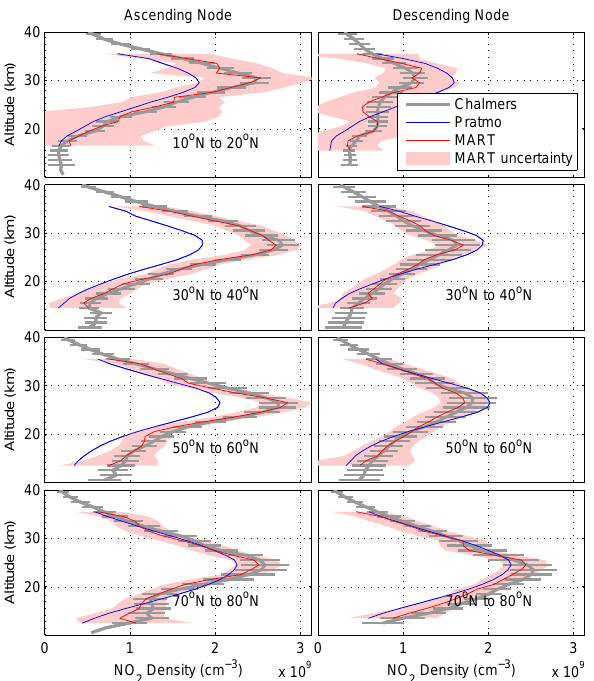
Fig. 5. Selected zonal mean profiles from one day of OSIRIS measurements. Each panel compares the zonal average of our re- trievals and the official OSIRIS version 3.0 product. Included in each panel is the zonal average of the apriori/initial guess profile (labeled Pratmo). In both cases, the uncertainty represents the aver- age uncertainty for a profile in the latitude bin. The range of solar zenith angles, in degrees, in each bin, from low to high latitude are: 81–87, 75–80, 70–74, and 67–69.